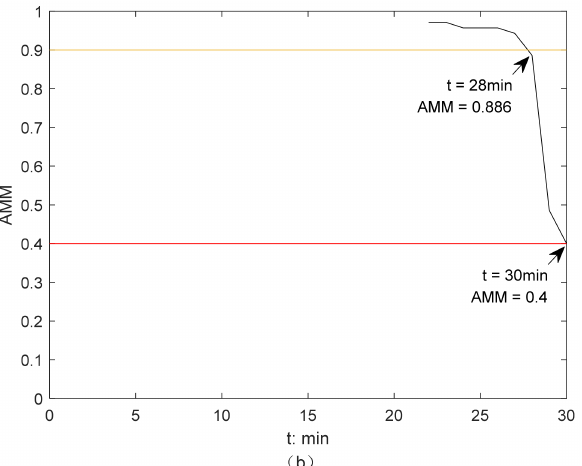
Figure 4. Illustration of the activation of AMM-based CAS from GW perspective in Scenario 1, without ship stability considered: ( a ) collision alert level determination; ( b ) the change of AMM of a GW.